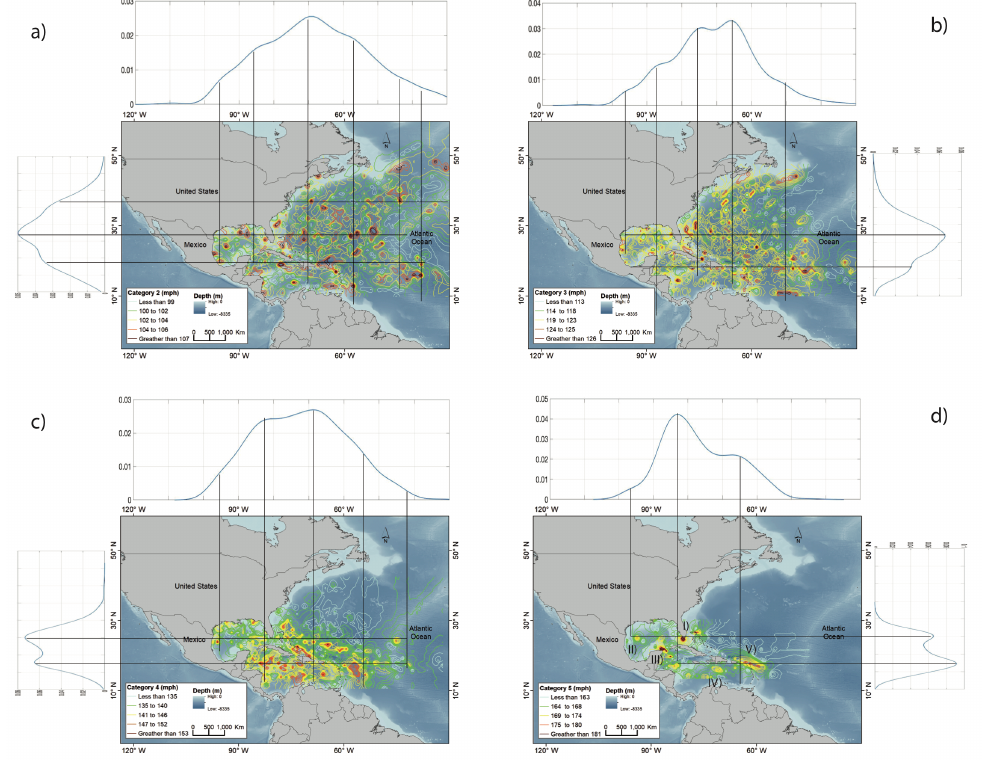
Figure 10. Probability distribution maps for the Atlantic hurricane wind speed for: ( a ) Category 2; ( b ) Category 3; ( c ) Category 4; ( d ) Category 5. The vertical and horizontal lines indicate the local maxima for the longitudinal and latitudinal distributions, respectively. The main point of this spatial clustering map is to indicate the possible connection between the climatic and geographical conditions for the development of maximum speed of Atlantic